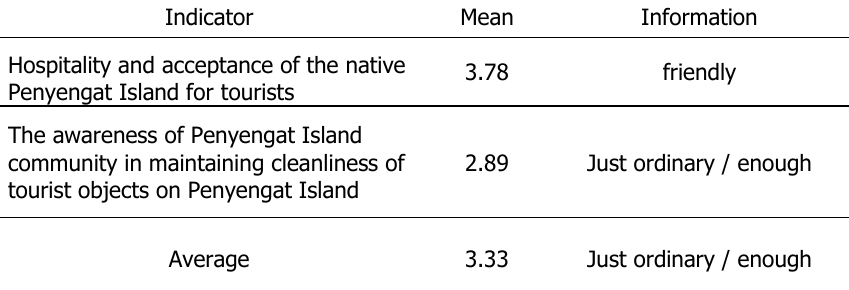
Table 8. Indicators of tourism awareness attribute